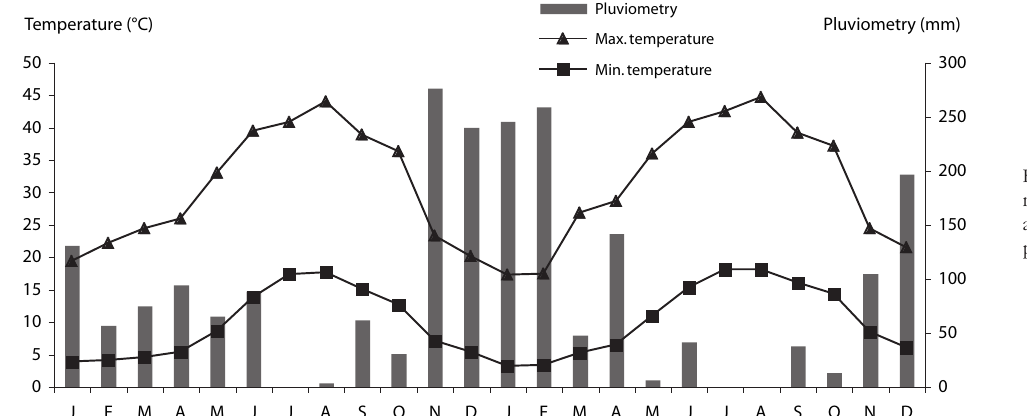
Fig. 1. – Mean monthly minimum and maximum air temperature for the period of